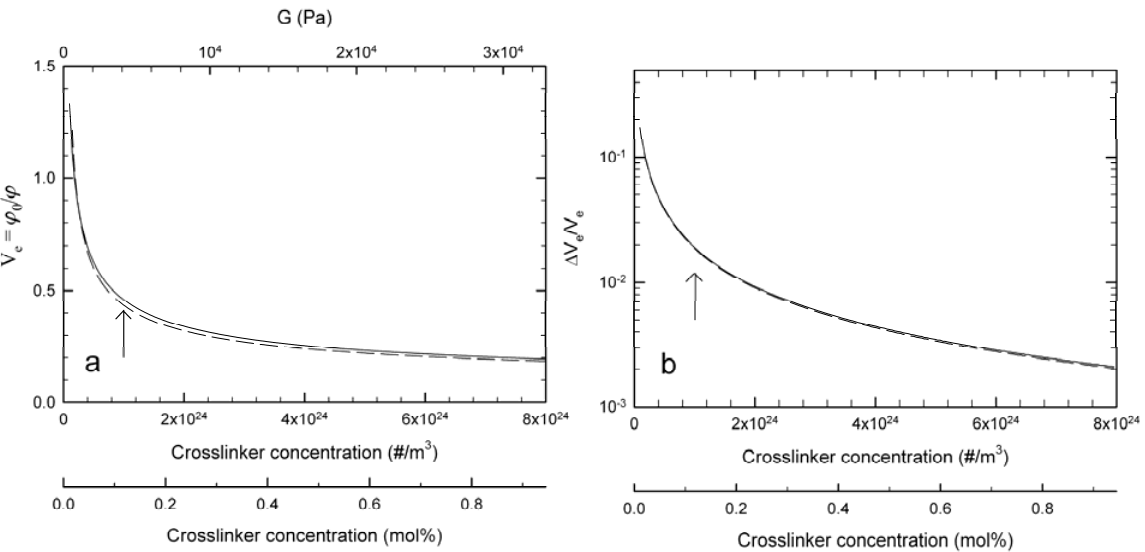
Figure 1. Example of simulation results showing the calculated equilibrium swelling ratio versus crosslink density (a) using Equation 2–5 for a 10% w/v hydrogel with charge ) of 2,500 g/mol e - density parameter equivalent molecular weight per charge (M 2 (continuous line) and uncharged polymer chains (broken line), Flory-Huggins interaction = 15, and ionic strength parameter c = 0.46, maximum elastic chain stretching ratio  max of 0.1 M monovalent type salt added to the aqueous solution (only for the charged network case) and at a temperature of 25 ºC. The network parameters are derived for a polyacrylamide based hydrogel and the crosslinker concentration is provided both in absolute numbers and mol% relative to the monomer of the polymer assuming a bis crosslinker. Additionally, an estimate of the shear storage modulus, G, over the range of hydrogel crosslinker densities are depicted (upper scale, Figure 1a). Figure 1b depicts the relative change in swelling volume versus crosslink density for the simulation depicted in Figure 1a. The arrows (Figure 1a,b) depict the crosslink density used in the calculations